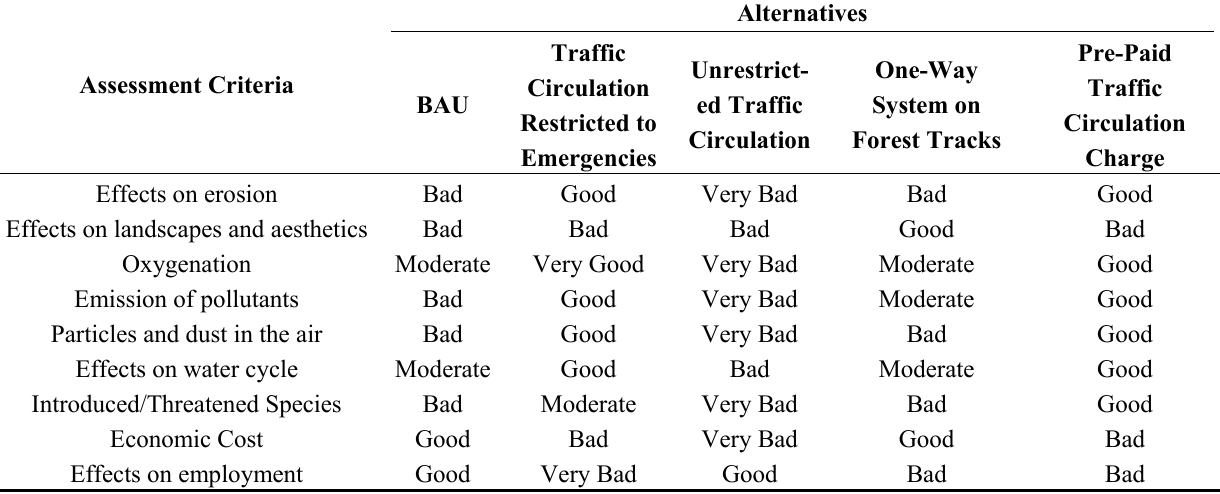
Table 5. Impact matrix: Planning